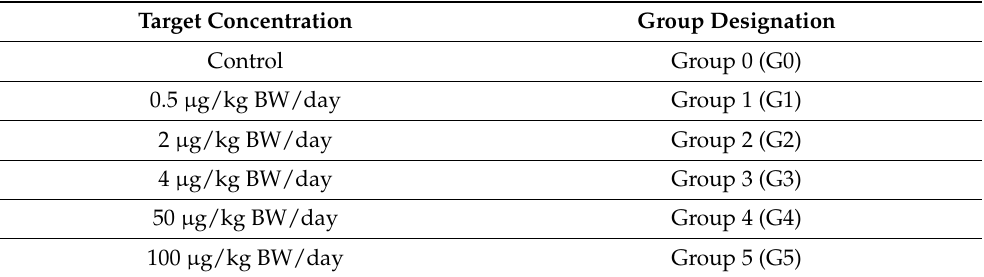
Table 1. Group designation and target concentrations.